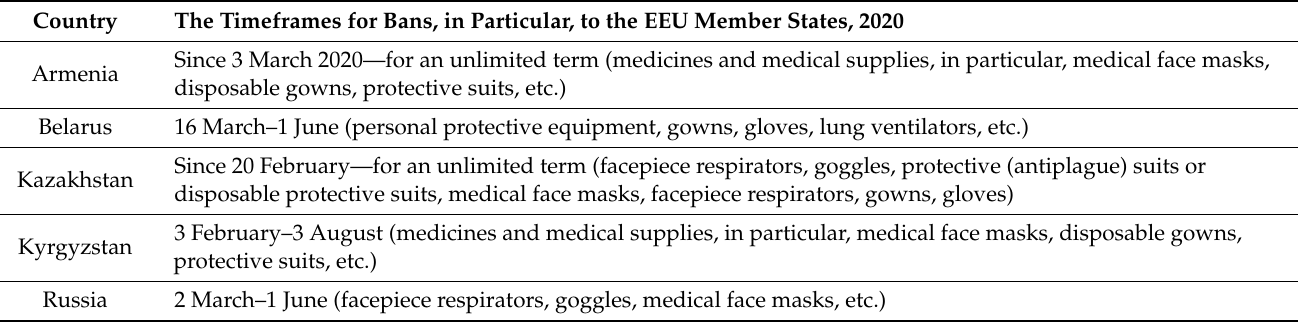
Table 2. The timeframe for the introduction of bans on the export of personal protective equipment, medicines, medical products, and other goods, in particular, to the EEU member